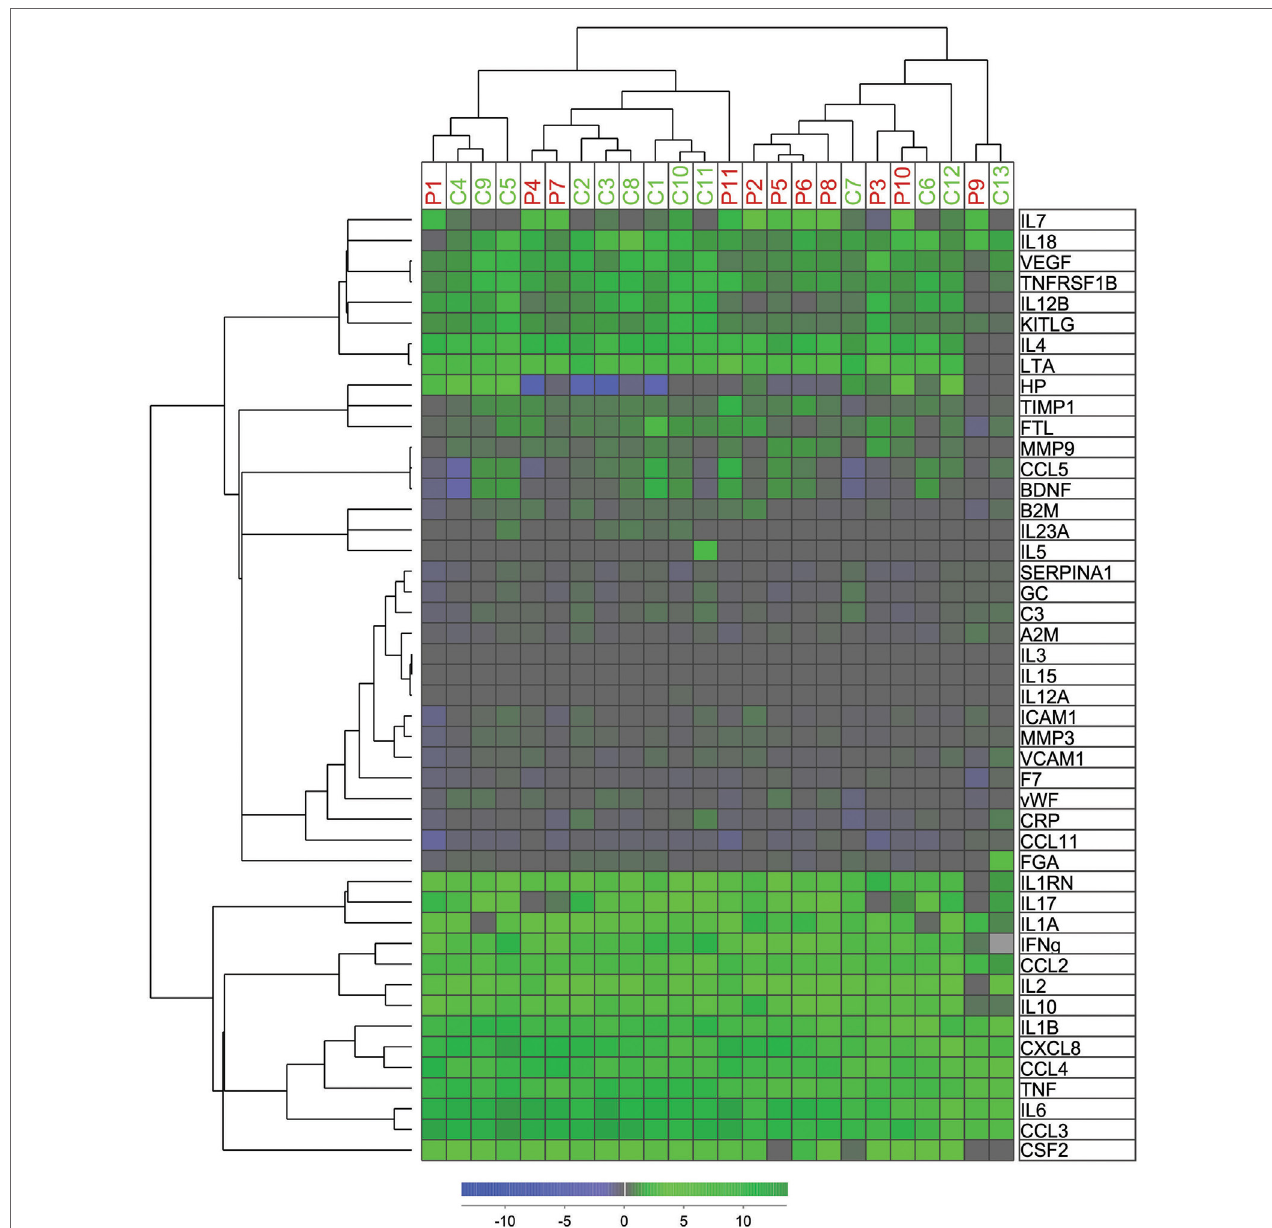
FigUre 2 | Hierarchical cluster analyses of mediator alteration in control and patients. Unsupervised hierarchical cluster analyses and distance matrix analyses for 11 patients (red P1–P11) and 13 controls (green C1–C13) were performed. Concentrations of mediators were measured before and after intervention as previously described. The alterations were standardized after ratio after/before intervention and log(2) transformed before unsupervised hierarchical clustering with Squared Euclidean distance measure with weighted average linkage was performed, resulting in a heat map for visualization and interpretation. The mediator alteration profiles identified to main patients/control clusters and two main cytokine